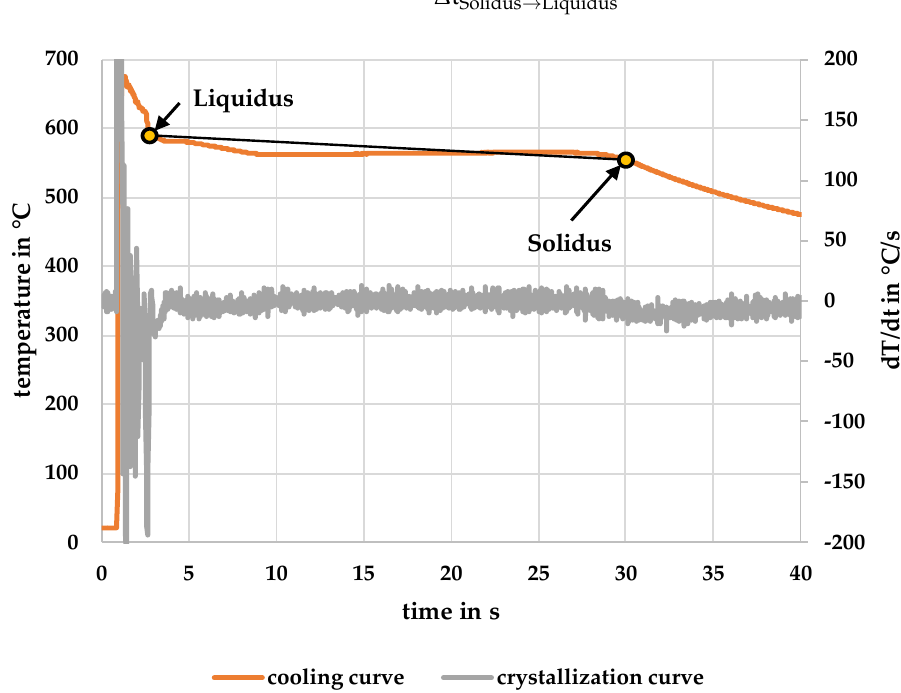
Figure 6. Example of a solidification curve for the step of thickness of 4 mm. The grey curve in Figure 6 corresponds to the first derivation of the solidification curve according to the cooling curve analysis method (CCA method) [25]. Due to this method, the liquidus and solidus temperatures were determined and afterwards the so- lidification rates were calculated.